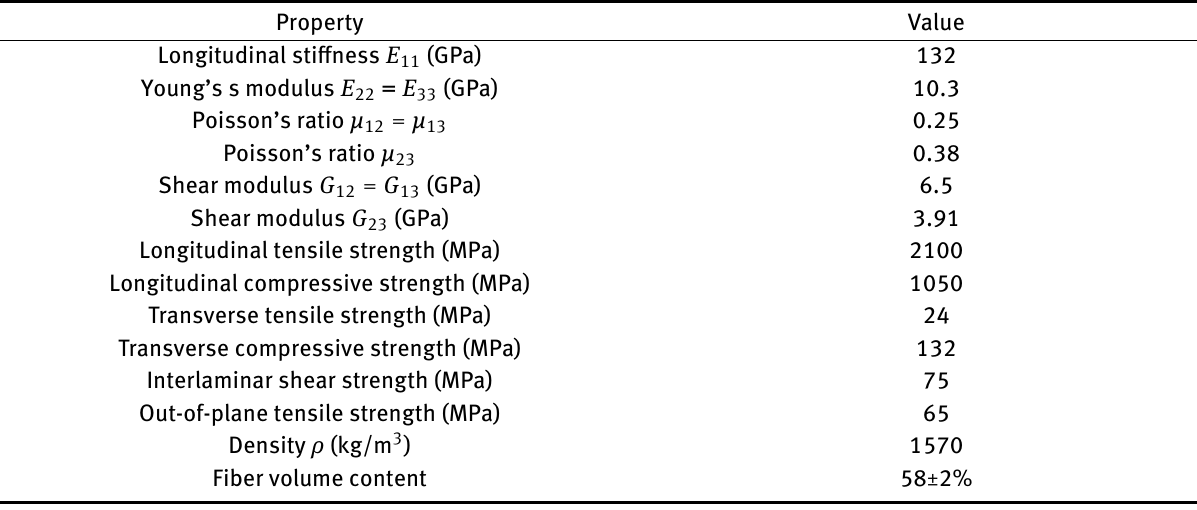
Table 1: Mechanical property of T700 / TDE85 composite materials